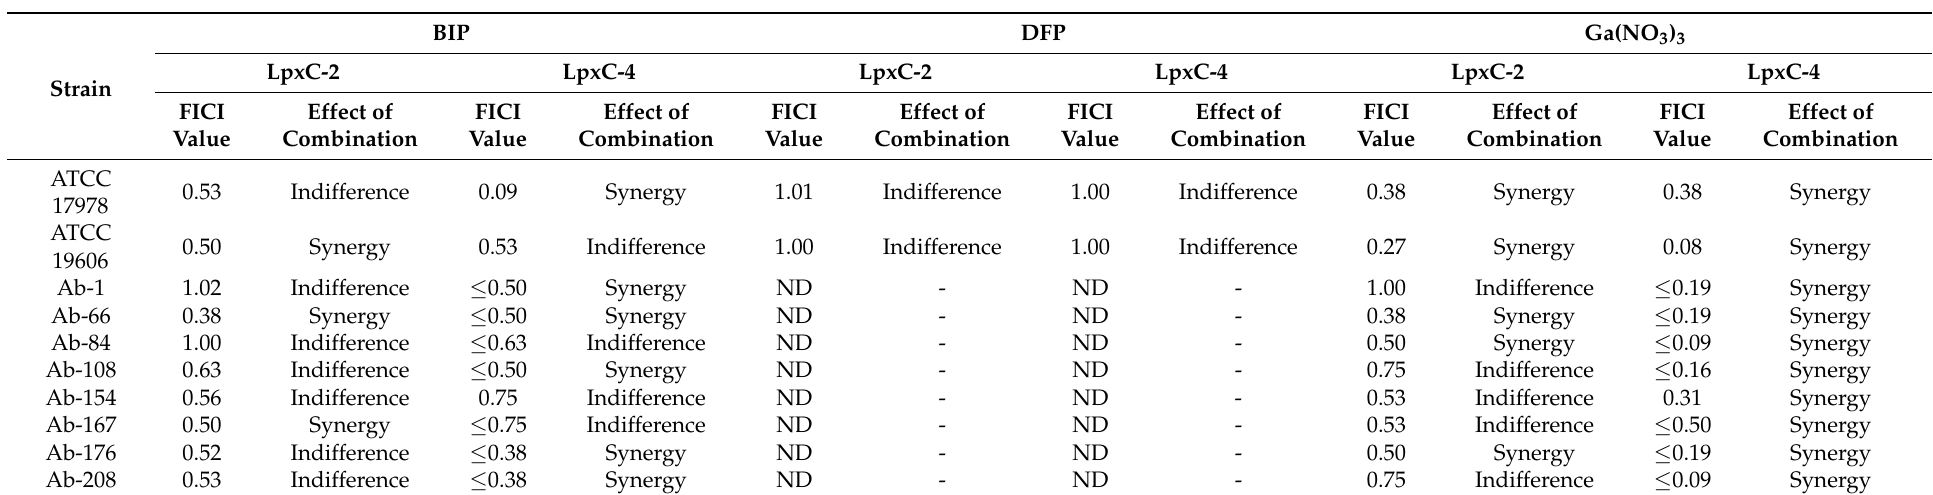
Table 2. Checkerboard assay for combinations of BIP, DFP and Ga(NO 3 ) 3 and LpxC inhibitors with a panel